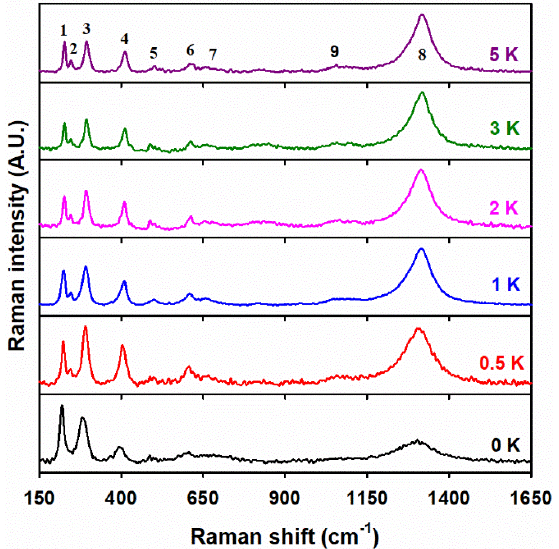
Figure 4. Raman spectra of 100 Fe: x K materials, with the atomic ratio of potassium ( x ) indicated in each panel. The numbers 1 to 8 correspond to modes of the hematite phase, while peak 9 relates to a mode of NO − in the range of 980–1150 cm –1 3